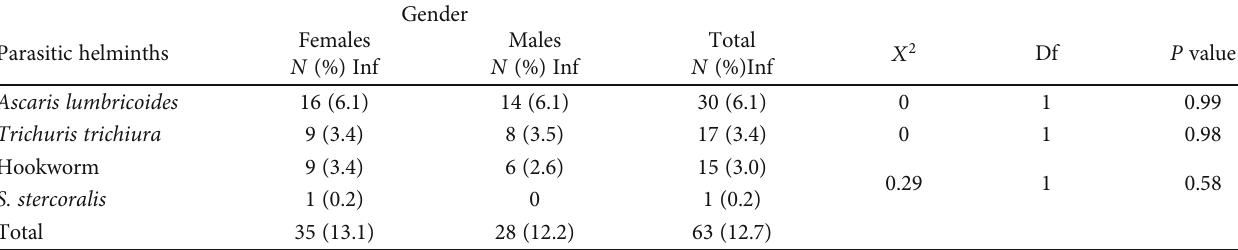
Table 3: Prevalence of parasitic helminths according to gender.